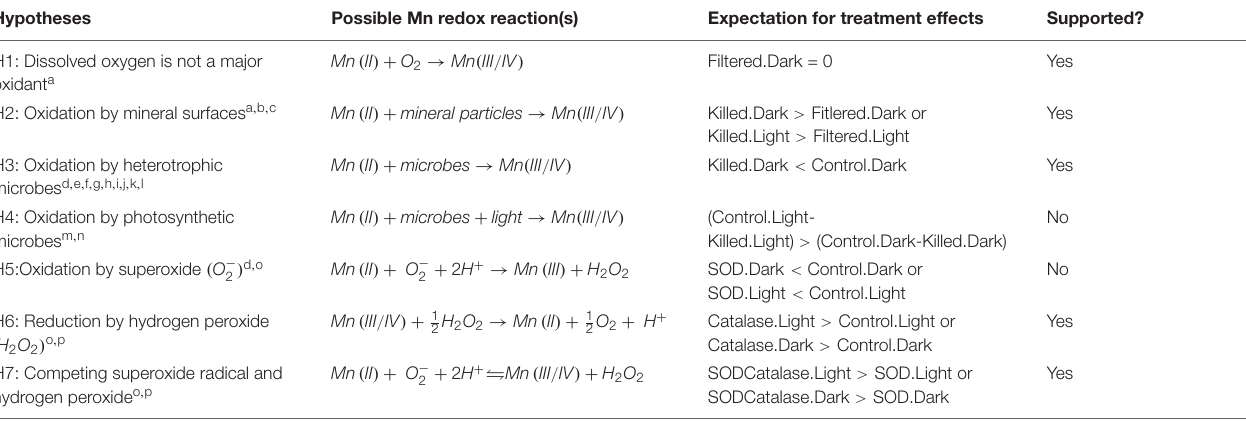
TABLE 1 | List of hypotheses, representative chemical reactions, and outcomes. Hypotheses Possible Mn redox reaction(s) Expectation for treatment effects